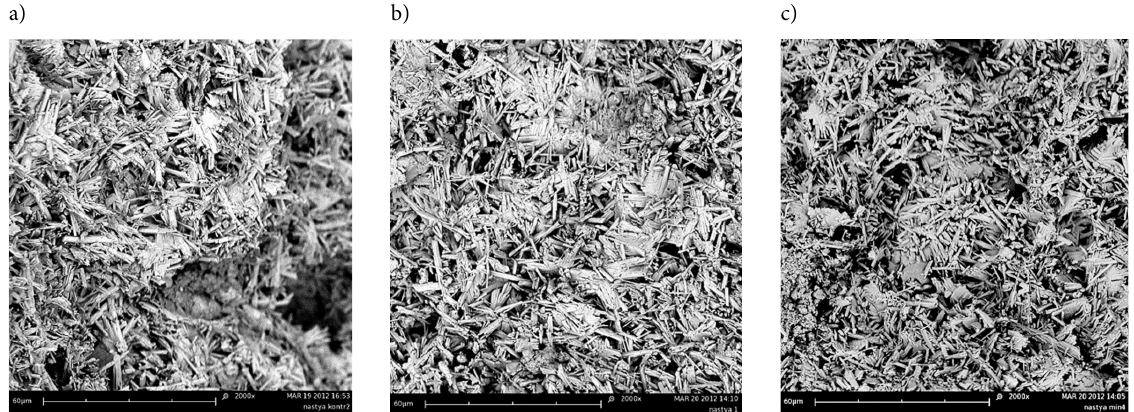
Fig. 8. Microstructure of the gypsum sample: a – control; b – modified with CNT suspension of 2-hour dispersion; c – modified with CNT suspension of 10-hour